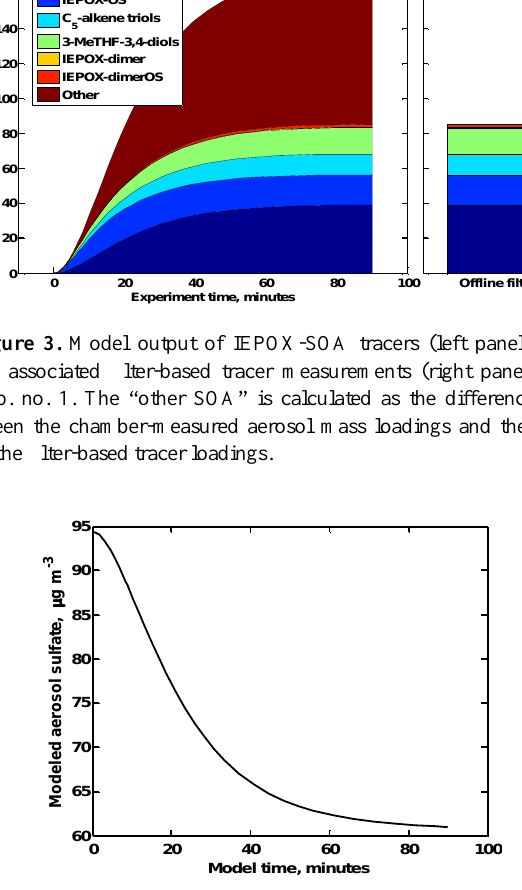
Figure 4. Model output of predicted titration of total inorganic aerosol sulfate ([SO 2 − ] + [HSO − ]) due to sulfated tracer forma- 4 4 tion during Exp. no. 1